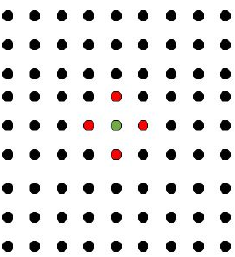
( b ) Figure 5. Crack path diagram ( a ) with the influence function, and ( b ) without the influence function. Figure 5a,b reveals that the calculated results after setting the influence function are in better agreement with the experiment shown in Figure 4. Accordingly, it is concluded that setting an appropriate influence function can improve the calculation accuracy.